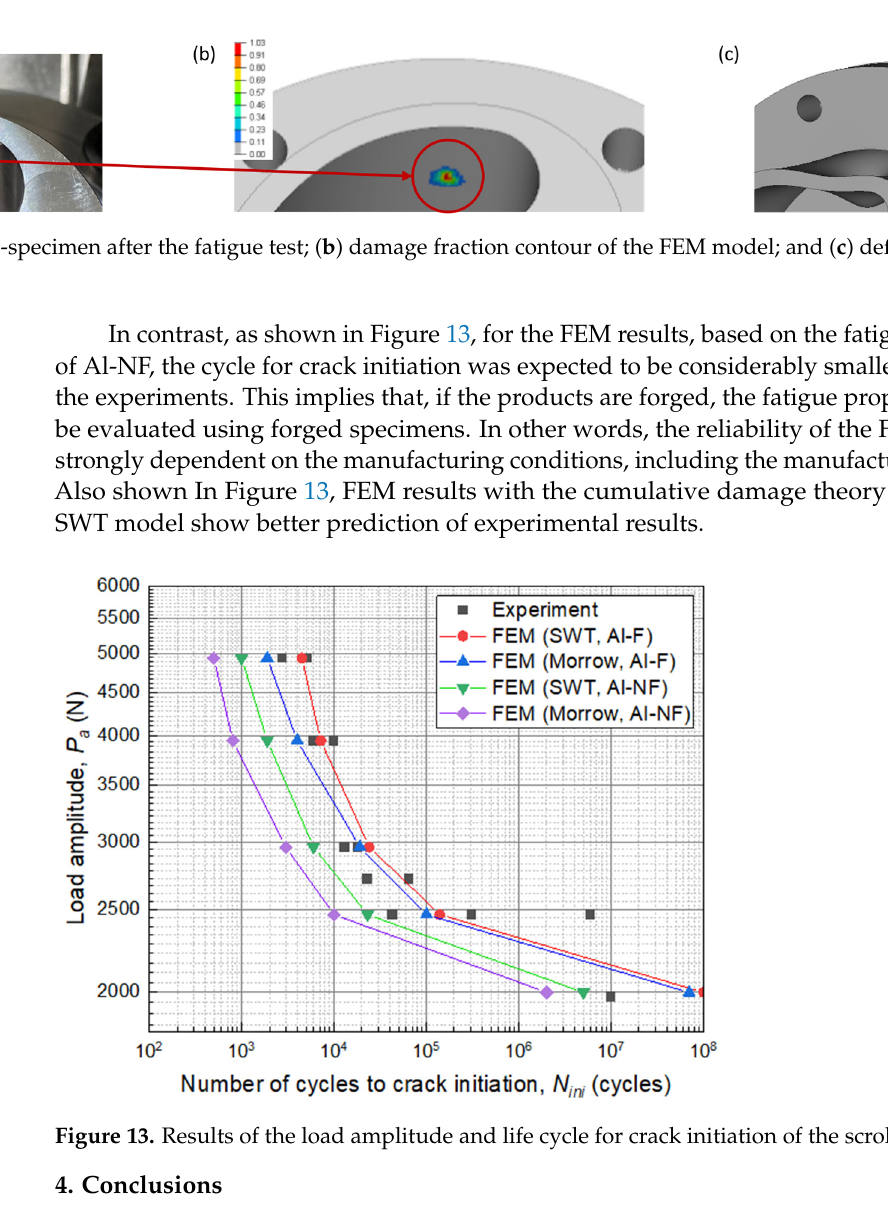
Figure 13. Results of the load amplitude and life cycle for crack initiation of the scroll C-specimen .